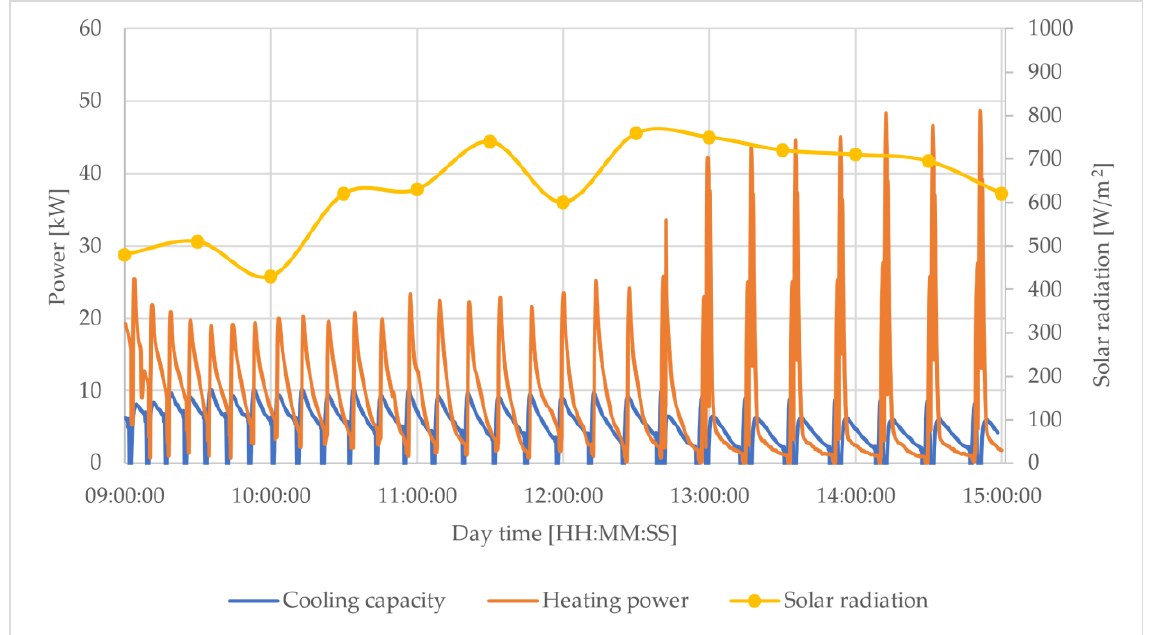
Figure 16. Fluctuation of heating and cooling power values over time for 6th August.